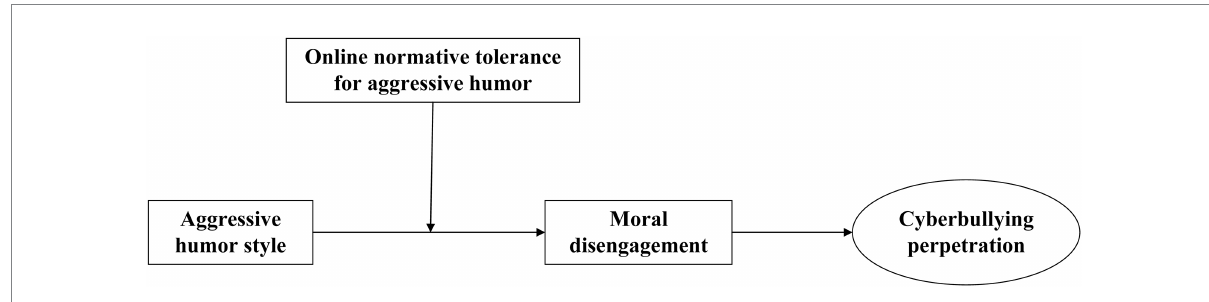
FIGURE 1 The proposed research